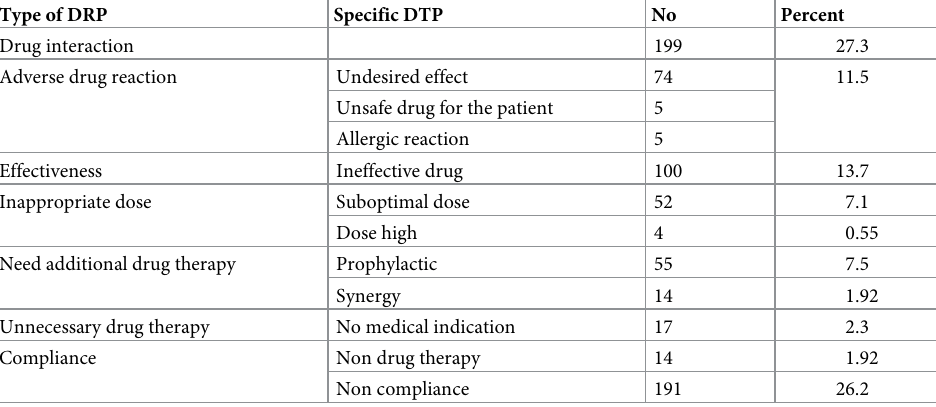
Table 5. Type of DTP identified from heart failure patients attending at the cardiac clinic of Tikur Anbessa Spe- cialized Hospital, Addis Ababa, Ethiopia June—August, 2017. Type of